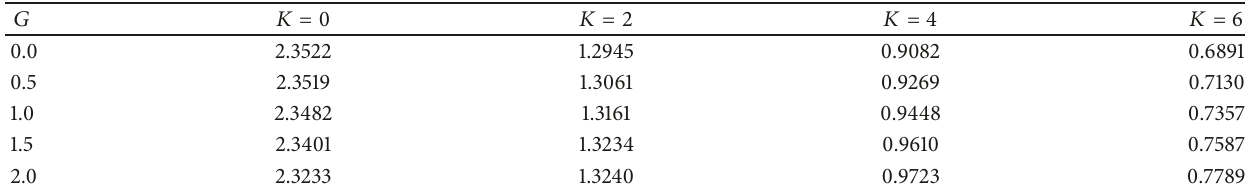
Table 1: |Ψ max min | against internal heating parameter with different 𝐾 for continuous case at 𝜙 = 0.1